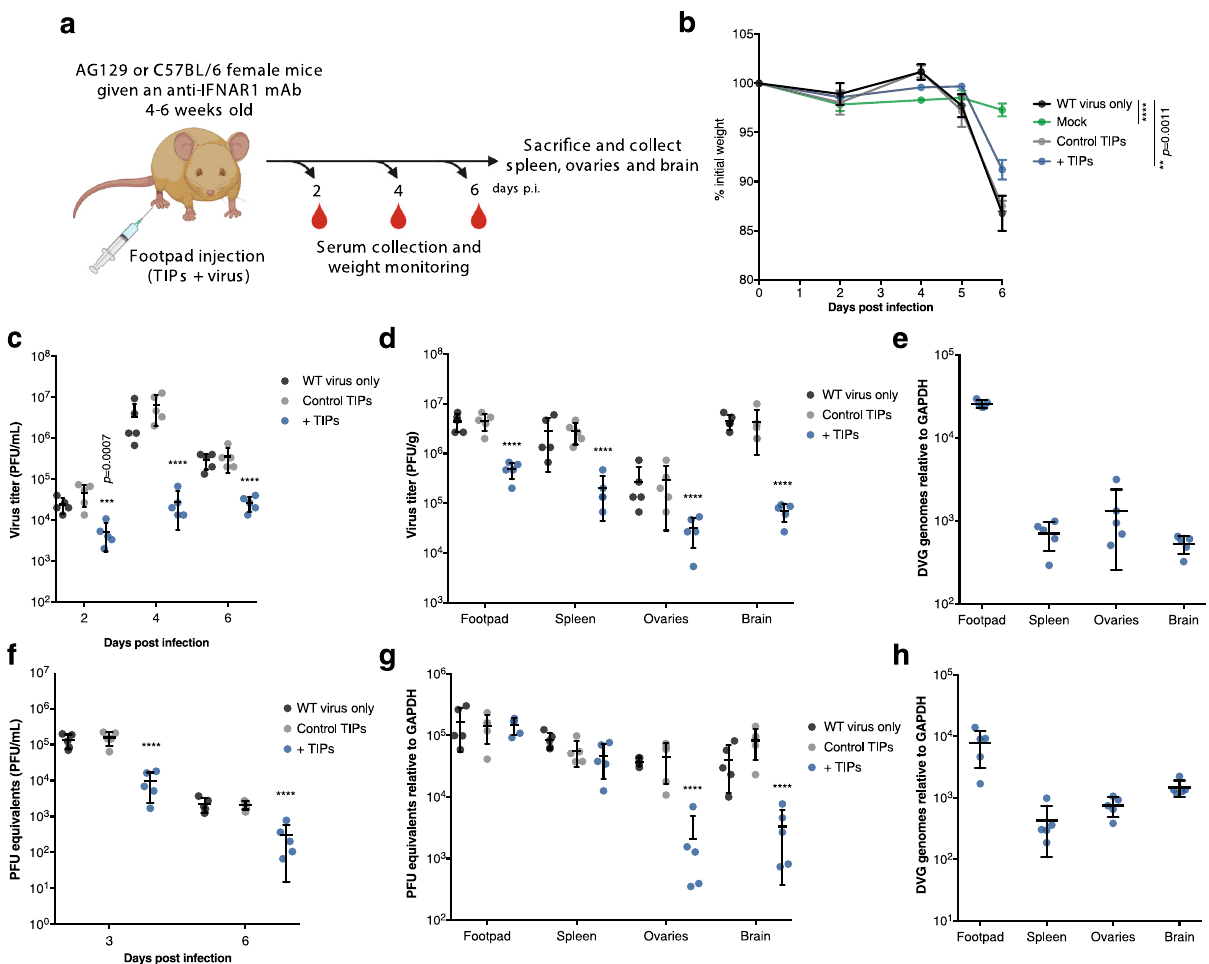
Fig. 5 Zika virus DVG-A-carrying TIPs inhibit virus replication in mice. a Experimental design. 4 – 6-week-old AG129 or C57BL/6 female mice were inoculated with WT virus diluted in DMEM, mock TIP supernatant (from transfections performed with no structural proteins), or with supernatant con fi rmed to contain DVG-packaging VLPs (TIPs). C57BL/6 mice were treated with 2 mg of IFNAR1-blocking monoclonal antibody 24 h prior to infection. At different times post-infection, sera were collected. 6 days p.i. mice were euthanized and organs harvested. b – e AG129 mice: ( b ) Weight loss of infected mice is shown as a % of weight at day 0 ( n = 5). **** p ≤ 0.0001. c Viremia on days 2, 4, and 6 post infection ( n = 5). **** p ≤ 0.0001. d Virus load in the injected footpad, spleen, ovaries and brain, 6 days p.i. ( n = 5) **** p ≤ 0.0001. e DVG amounts in all organs collected measured by RT-qPCR ( n = 5). f – h C57BL/6 female mice that were given an IFNAR1-blocking monoclonal antibody 24 h prior to infection. f 3 and 6 days p.i. viremia was measured by RT- qPCR and is depicted as PFU equivalents/mL ( n = 5). **** p ≤ 0.0001. g 6 days p.i. mice were euthanized and virus load in organs measured by RT-qPCR ( n = 5). **** p ≤ 0.0001. h DVG-A amounts in all organs measured by RT-qPCR ( n = 5). All graphs show the mean and SD; n = 5. In all cases, two-way ANOVA with Dunnet ’ s multiple comparison was carried out comparing each condition to mice infected with WT virus only. Source data are provided as a Source Data fi